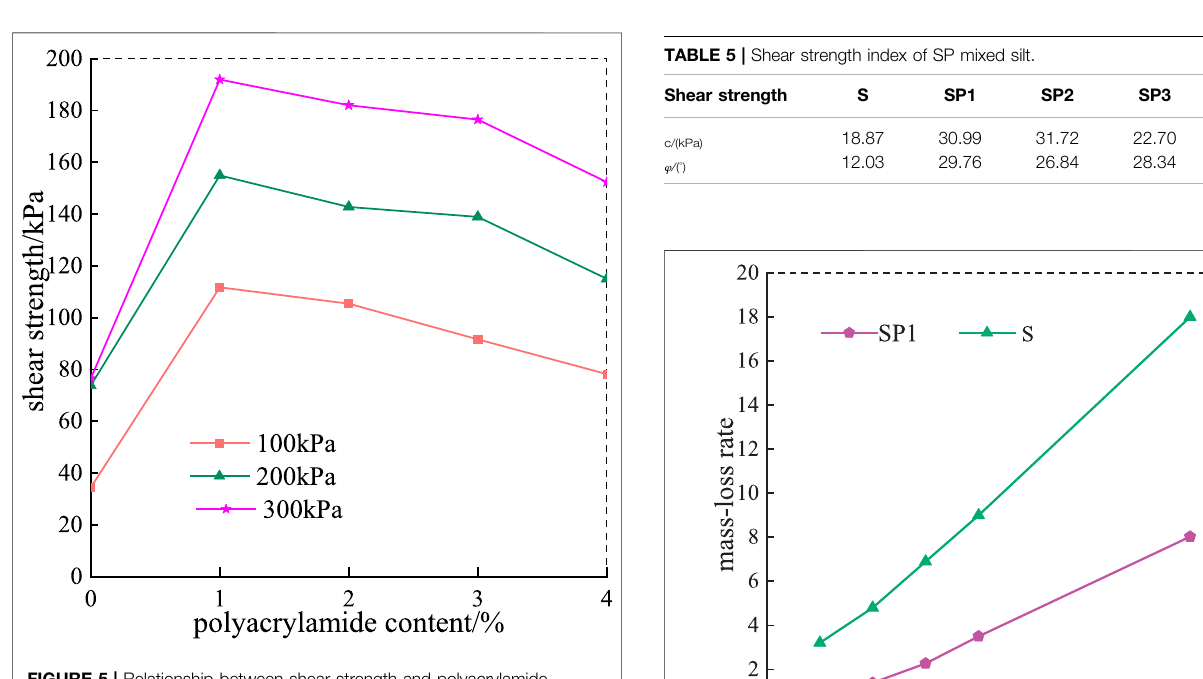
FIGURE 5 | Relationship between shear strength and polyacrylamide content.